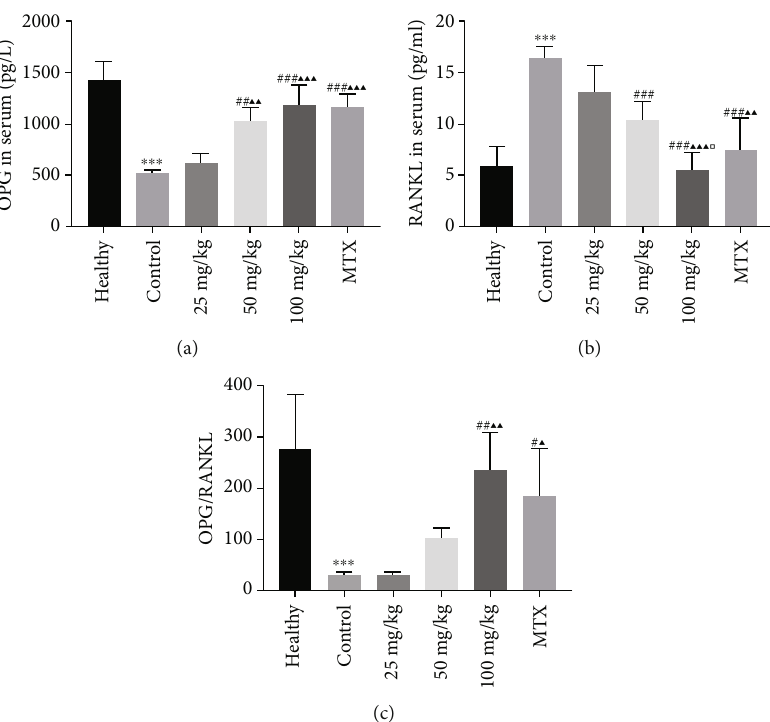
Figure 6: The level of OPG and RANKL expression in the serum assessed by an ELISA. (a) The level of OPG expression in the serum; (b) the level of RANKL expression in the serum; (c) the expression of OPG/RANKL. Healthy: healthy group; control: CIA control group; 25 mg/kg: low dosage matrine group; 50mg/kg: medium dosage matrine group; 100mg/kg: high dosage matrine group; MTX: 2 mg/kg methotrexate group. Compared to the healthy group, ∗∗∗ P < 0 : 001 ; compared to the control group, # P < 0 : 05 , ## P < 0 : 01 , and ### P < 0 : 001 ; compared to the 25 mg/kg group, ▲▲ P < 0 : 01 , ▲▲▲ P < 0 : 001 ; compared to the 50mg/kg group, □ P < 0 : 05